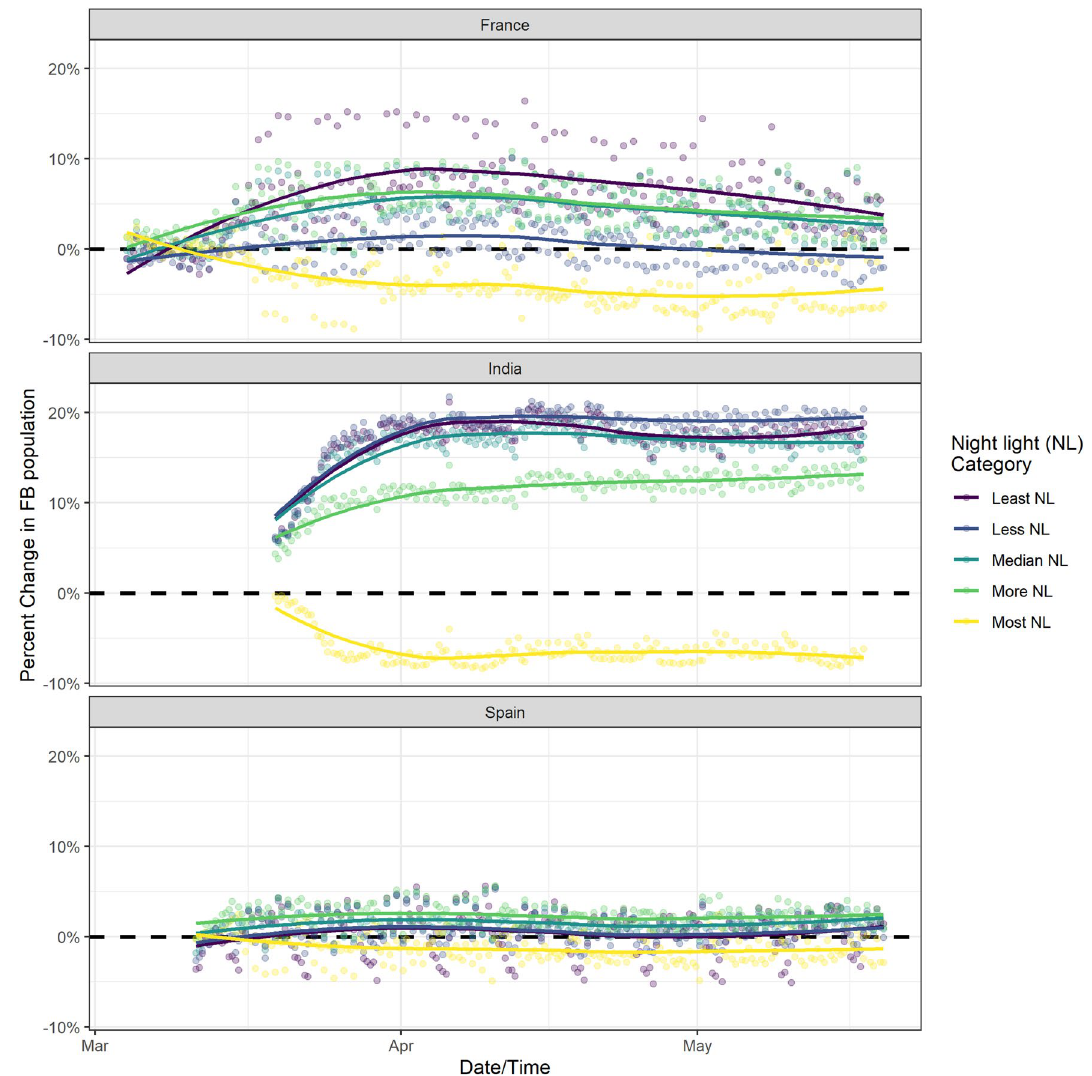
Figure 3. Percent change in population of Facebook users categorized by five equally sized quantiles of nightlight by country with data aggregated at the ADMIN3 level of spatial